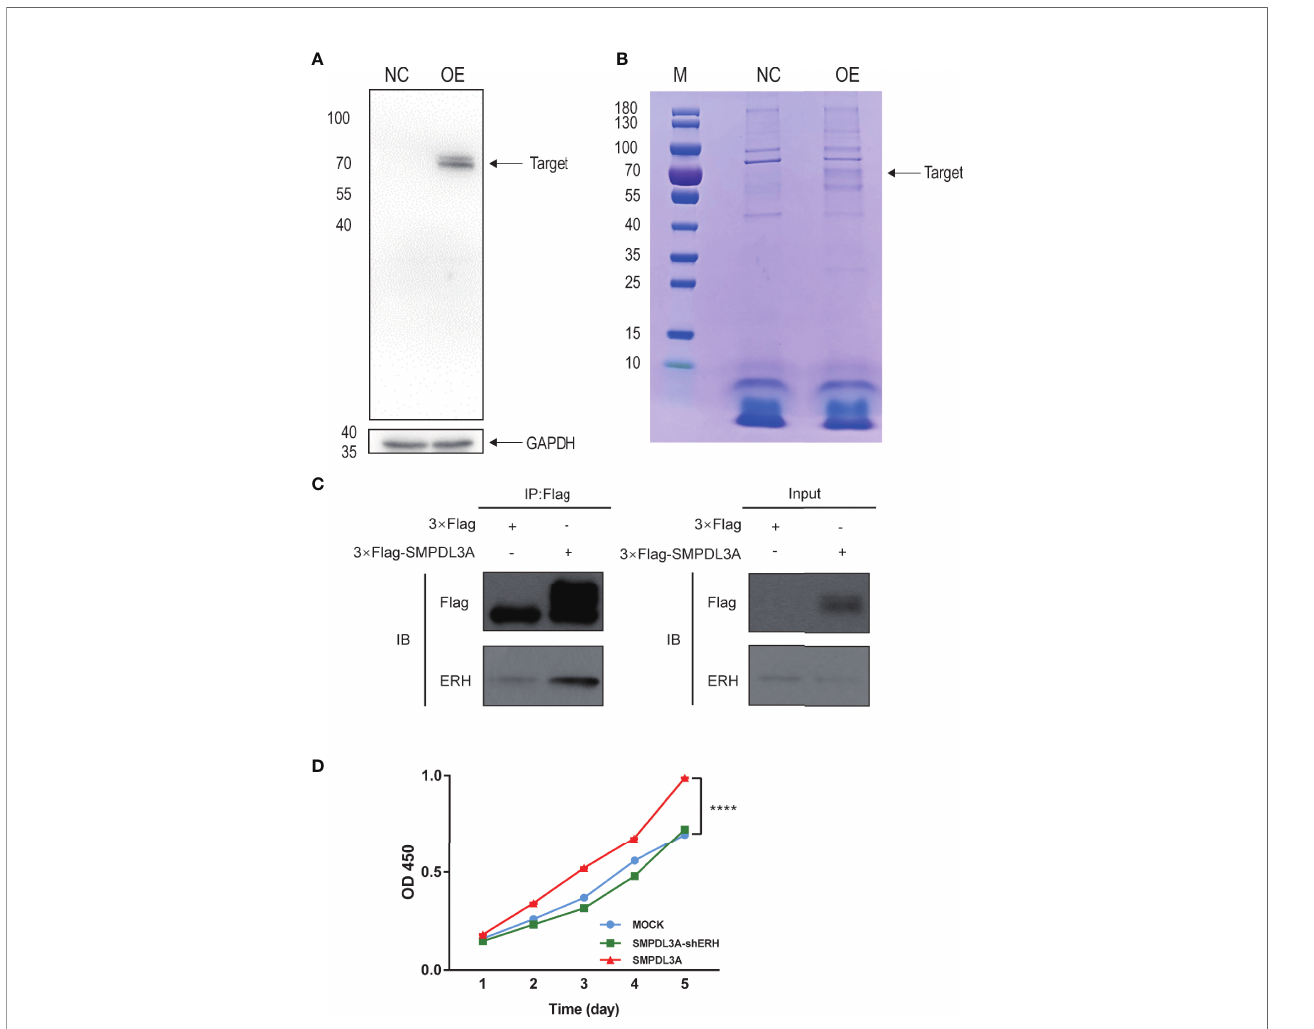
FIGURE 8 | Interactions between SMPDL3A and ERH. (A) The liver cancer cells overexpressing SMPDL3A were successfully detected by western blotting. (B) Coomassie brilliant blue staining, indicating the presence of a 72-kDa protein band in the protein gel. (C) Veri fi cation of the interaction between SMPDL3A and